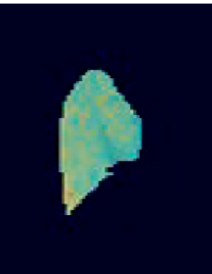
Figure A3. Only the CT and PET information of 64 × 64 × 96 pixels within the liver is retained.